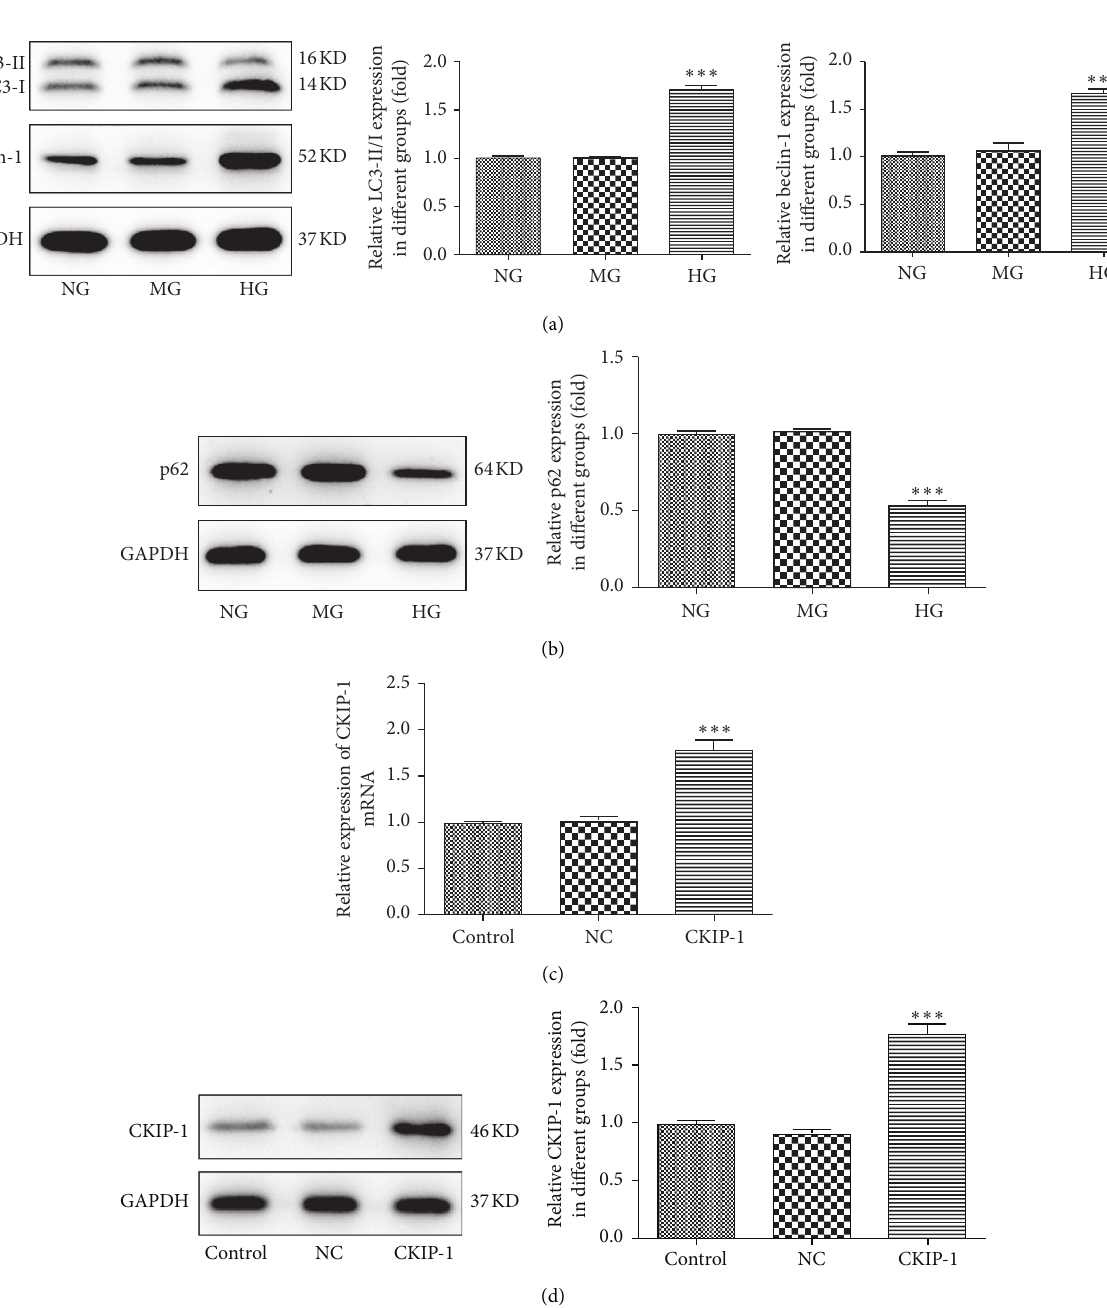
Figure 2: High glucose induced activation of autophagy in ARPE-19 cells. (a) Expression levels of the autophagic marker LC3 and Beclin-1 were determined by Western blots. (b) The expression of the autophagic substrate p62 was determined by Western blots. The transfected efficacy of CKIP-1 was evaluated by RT-PCR (c) or Western blots (d). ∗∗∗ p < 0.001 vs. NG; ∗∗∗ p < 0.001 vs. control. NG, normal glucose (5.5mM); MG, mannitol (20mM); HG, high glucose (25 mM); NC, pcDNA3.1 vector; CKIP-1,